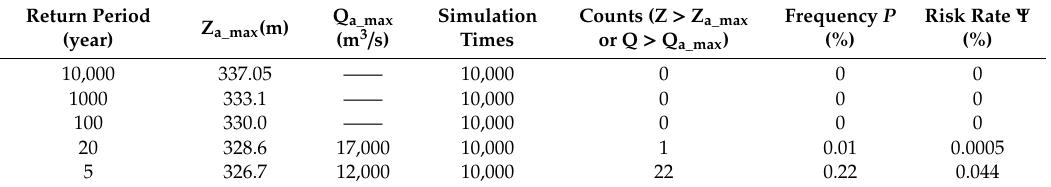
Table 5. The risk estimation results for FBO for floods with different return periods.